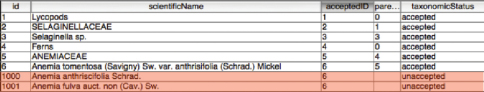
Synonym records (highlighted) added and linked.